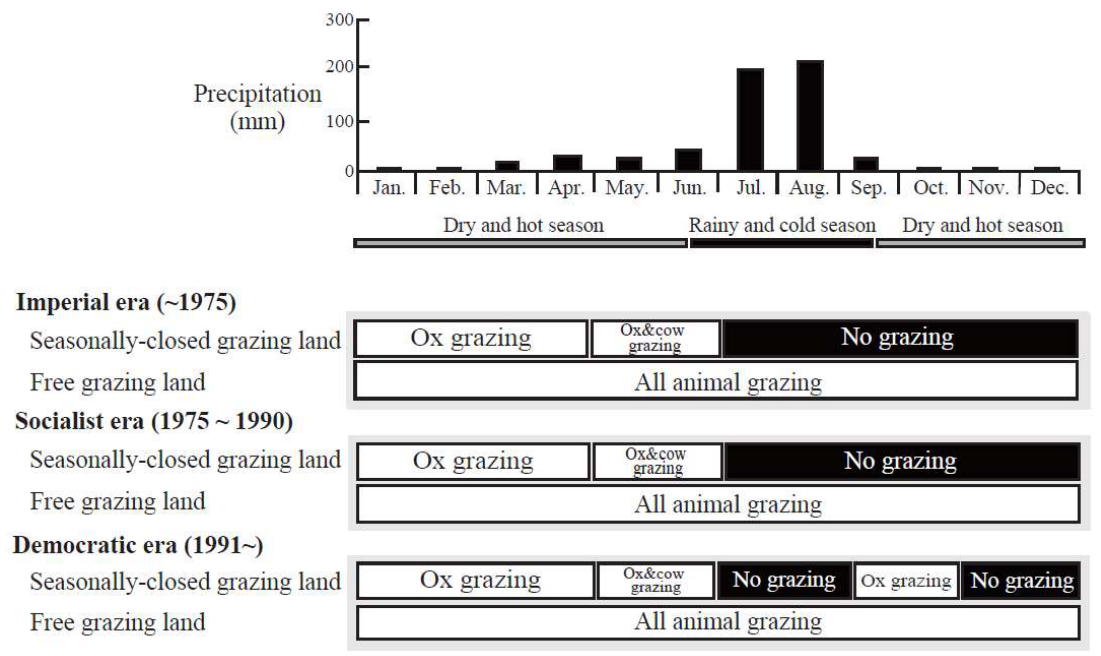
Figure 2. Changes in land management in the Adi Zaboy watershed during the imperial, socialist, and democratic eras.